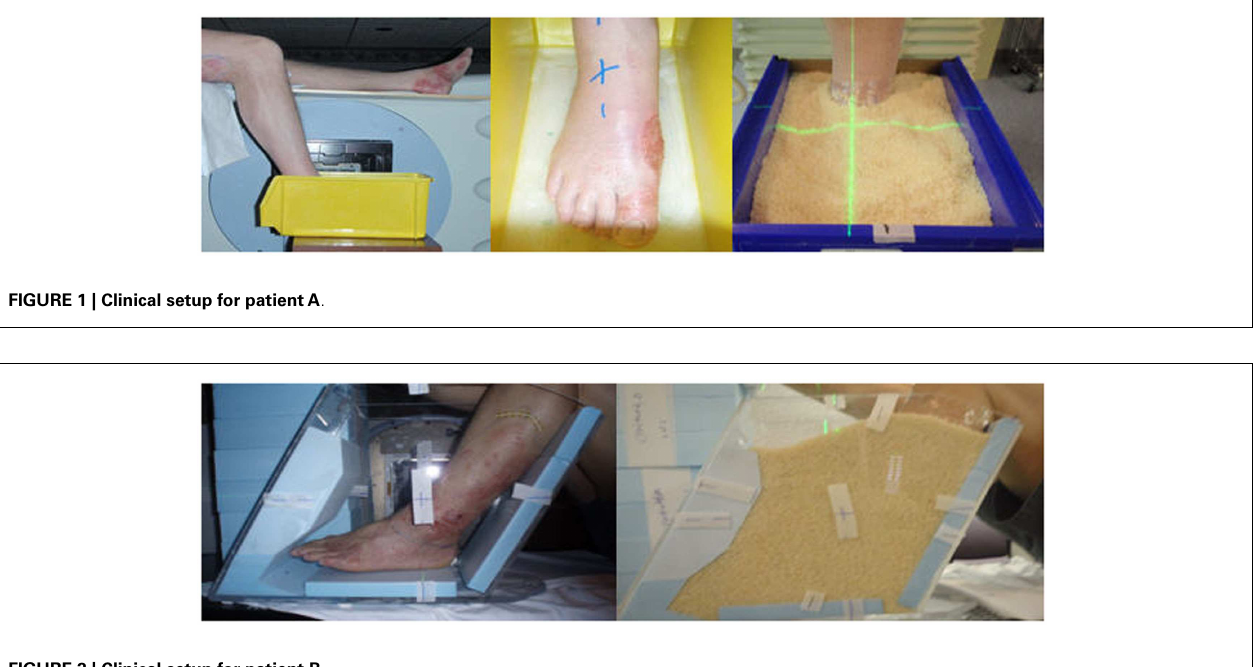
FIGURE 2 | Clinical setup for patient B